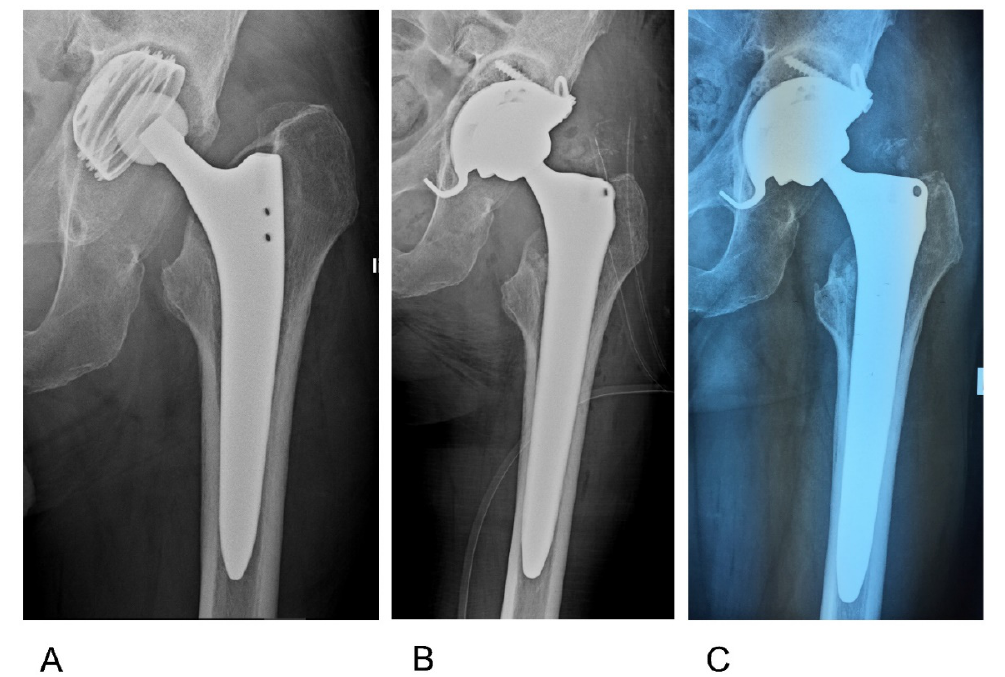
Figure 8: A 66 year old male who sustained a femoral neck fracture treated with uncemented THR. Postoperatively he complained of unspecific pain with only slightly elevated infection markers. A) 3 years later loosening of the acetabular component was diagnosed with marked osseous defect periacetabular and signs of osteolysis around the proximal part of the stem. B) One stage exchange with uncemented components. The defects were filled with antibiotic impregnated bone Osteomycin V TM. Sonification of explanted material revealed growth of 2 strains of S.epidermidis (MSSE) and Propionibact. sp. Hospital stay was one week, with Cefuroxim intravenously, followed by 6 weeks Amoxicillin/Clavulanic acid + Rifampicin orally. C) 6 months postop: The patient is painfree with no sign of infection and unlimited mobility. There is partial remodelling of the allograft material with no sign of loosening of